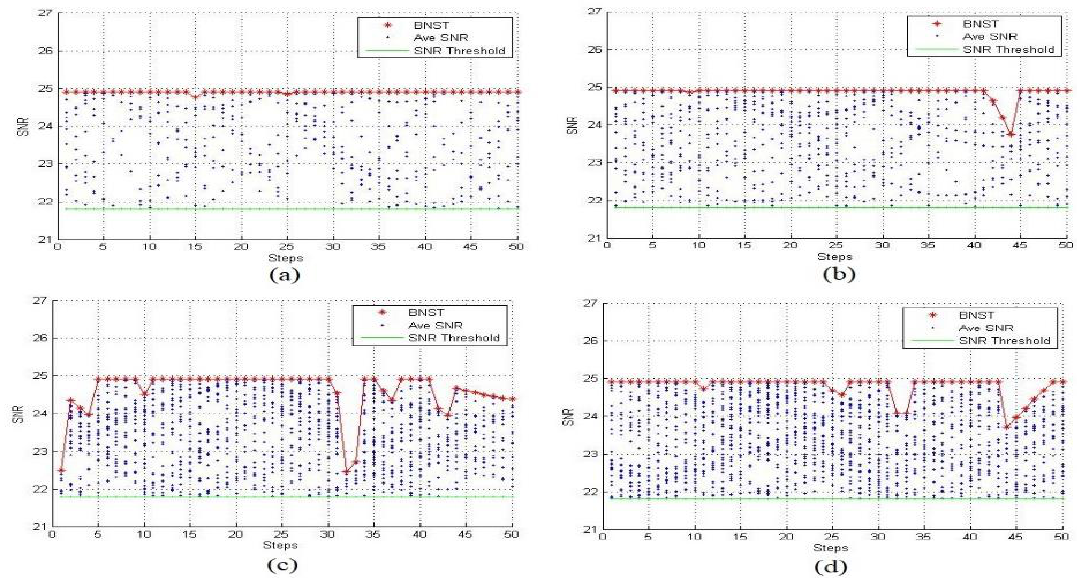
Figure 8. The BNST, the SNR threshold and the average SNR computed at each boundary nodes when the jammer’s transmission range is changed: ( a ) jammer’s transmission range = 15 m; ( b ) jammer’s transmission range = 20 m; ( c ) jammer’s transmission range = 30 m; and ( d ) jammer’s transmission range = 35 m.